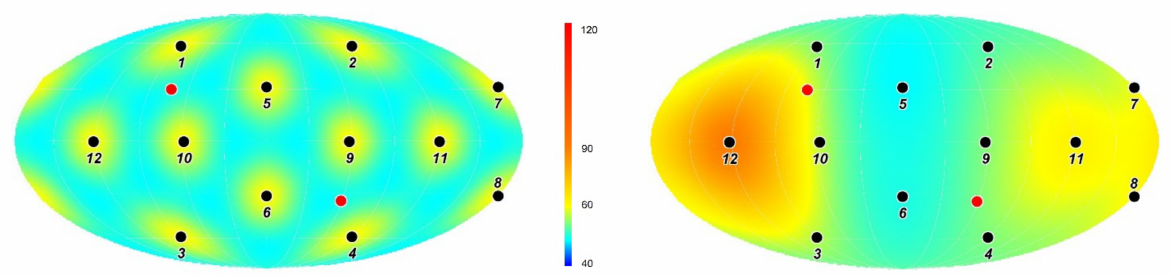
Figure 25. Spatial distribution of NH 3 after 100 Martian years: “factory” alternative variant ( left ), “asteroid” alternative variant ( right ).